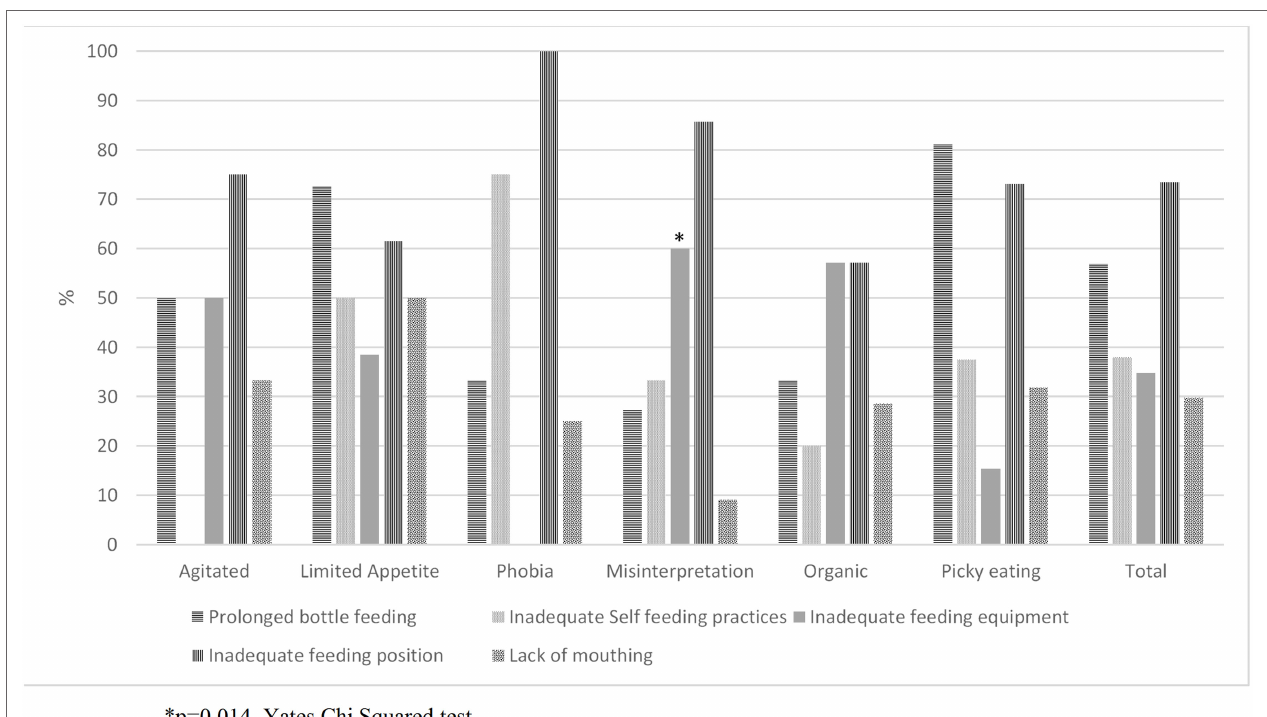
FigUre 1 | Prevalence of inadequate feeding skills according to types of feeding